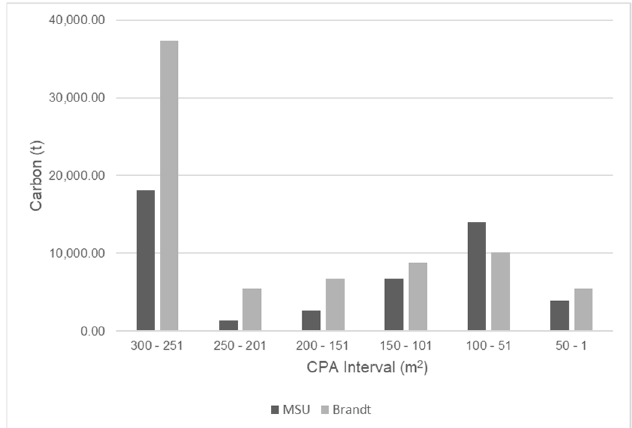
Figure 10. Contribution to the total landscape carbon (Mg) by trees in different size classes. Shown are results from this study compared to Brandt et al. for trees in a sequence of 50 m 2 CPA intervals. The largest differences were trees in the 251–300 m 2 CPA interval.